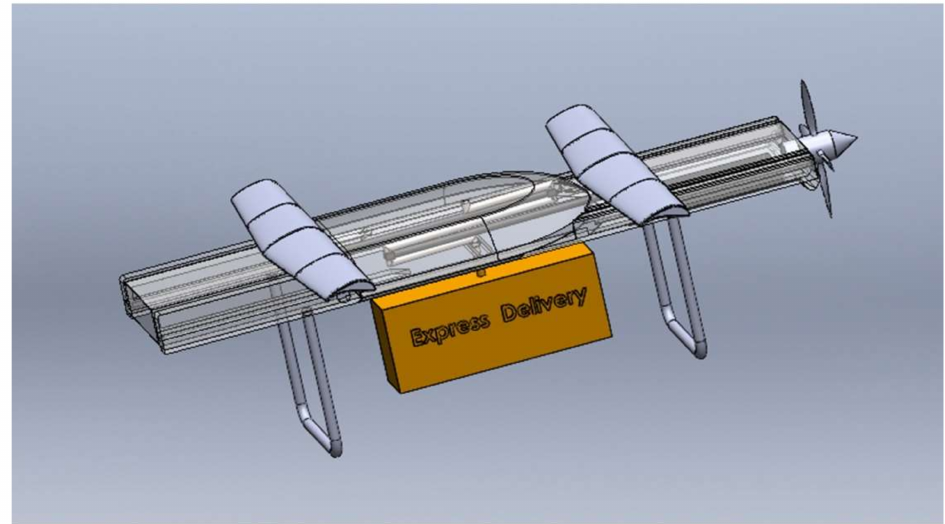
Figure 6. Schematic of a Reciprocating-Wing Driven VTOL UAV Model.